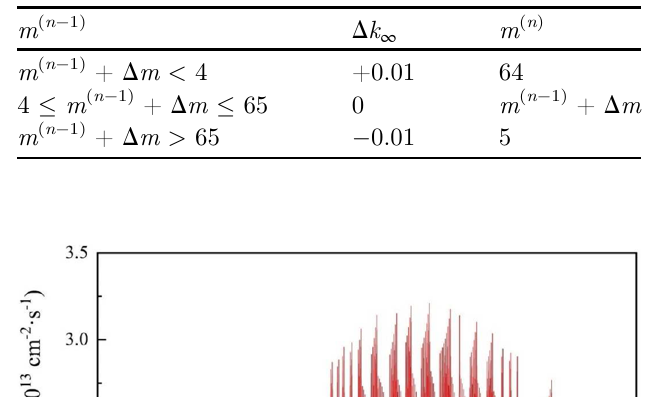
Table 4. Adjustment rules of the control rod at extreme positions.